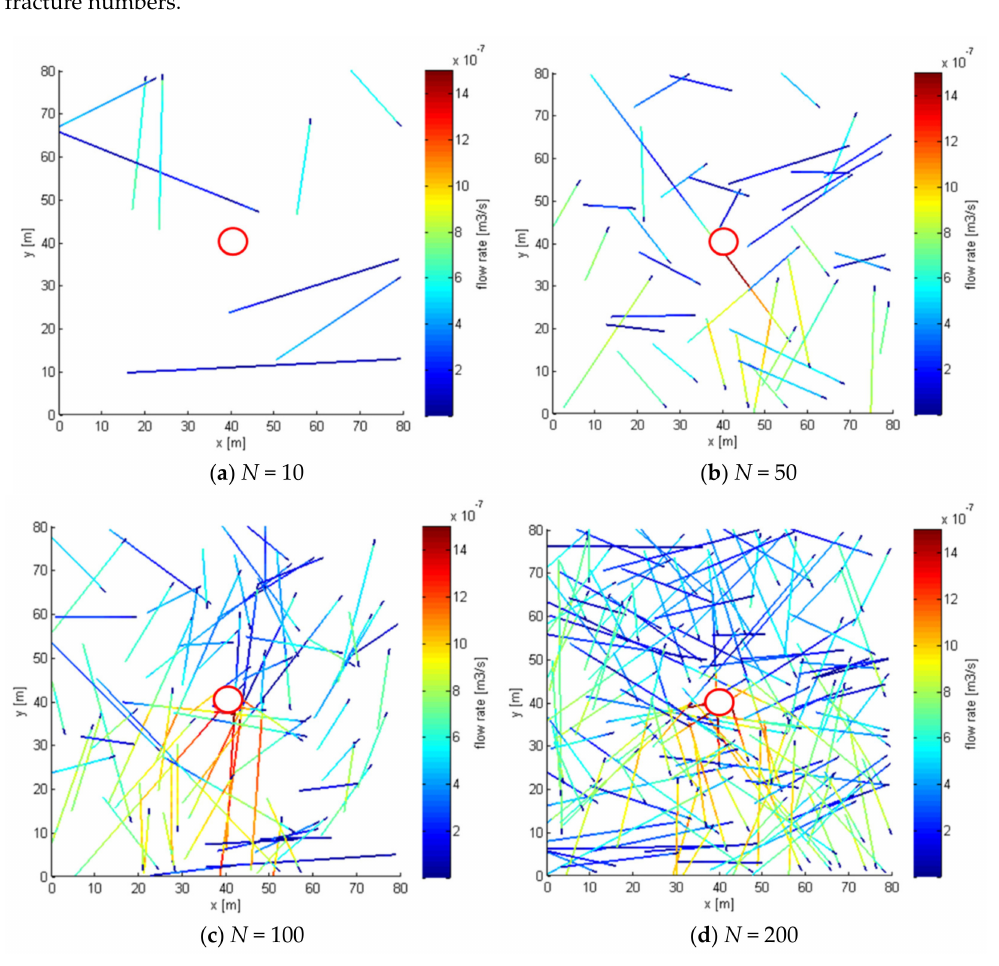
Figure 12. Fracture flow rate distribution under different fracture numbers. It is also noted that the representativeness of fracture distribution uses two parameters, namely fracture heterogeneity and density. This work focus on the effects of fracture heterogeneity and density on flow behavior in the tunnel. Although the generation